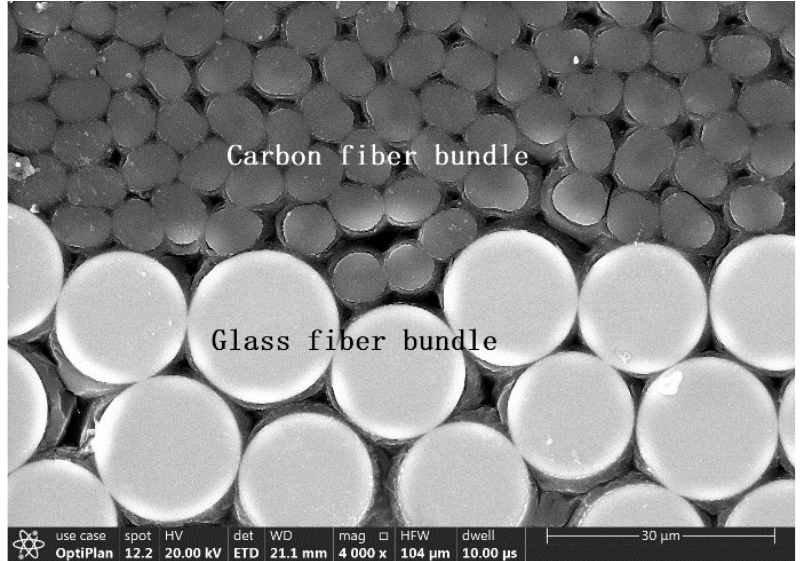
Figure 1. Image of the hybrid composite.